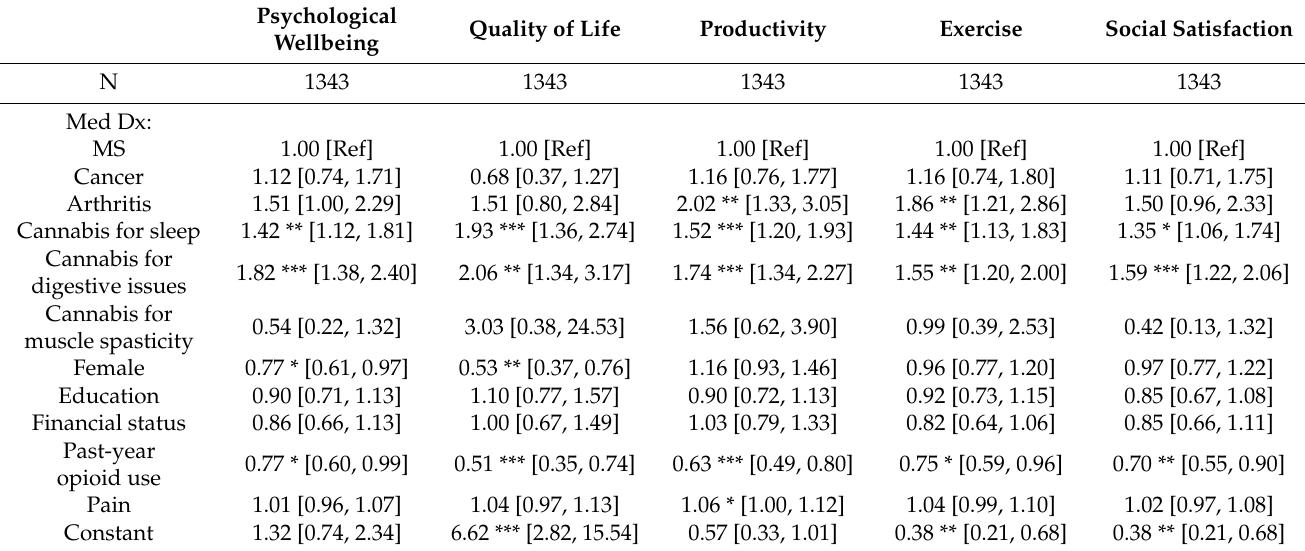
Table 2. Logistic regression results showing relationship between cannabis use and self-reported outcomes of